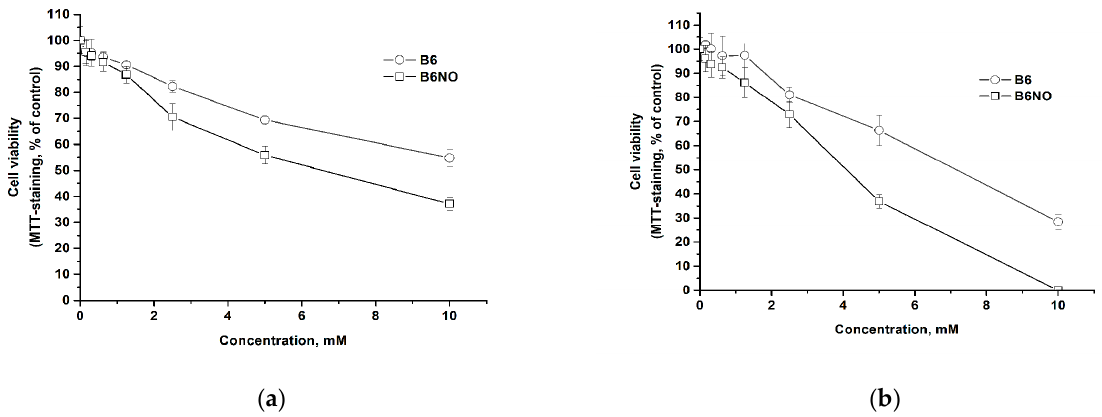
Figure 4. Dose-response curves for normal Vero ( a ) and cancer HepG2 ( b ) cells after 24 h of B6NO and vitamin B6 exposure. It has been determined that both the hybrid compound and pyridoxine have low cytotoxicity. It should be noted that B6NO has a slightly higher cytotoxicity than